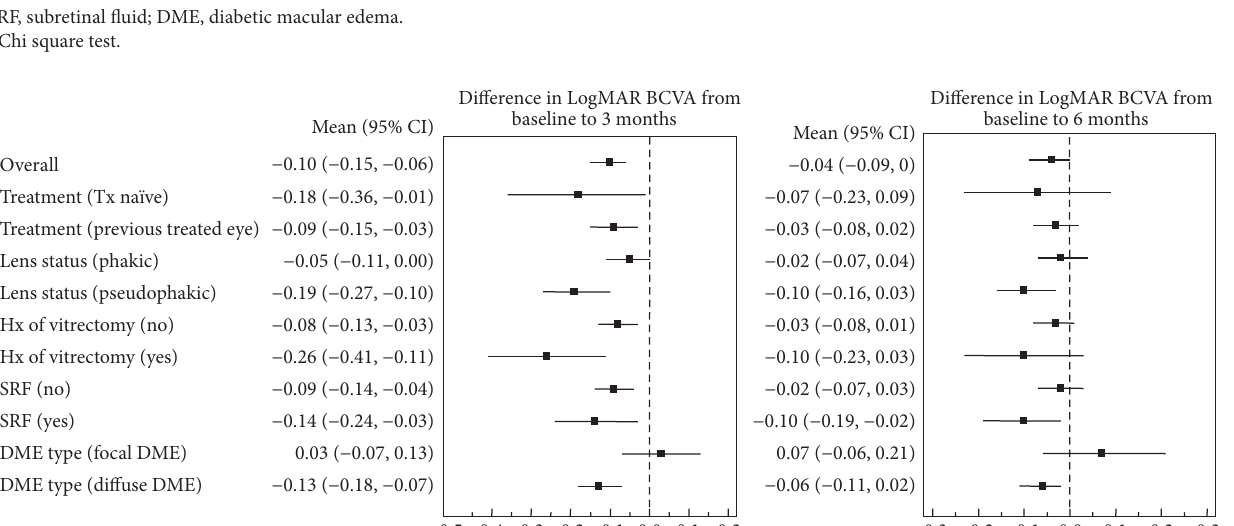
in the diffuse DME group than in the focal DME group (mean difference = 0.107; 𝑝 = 0.025 , Figure